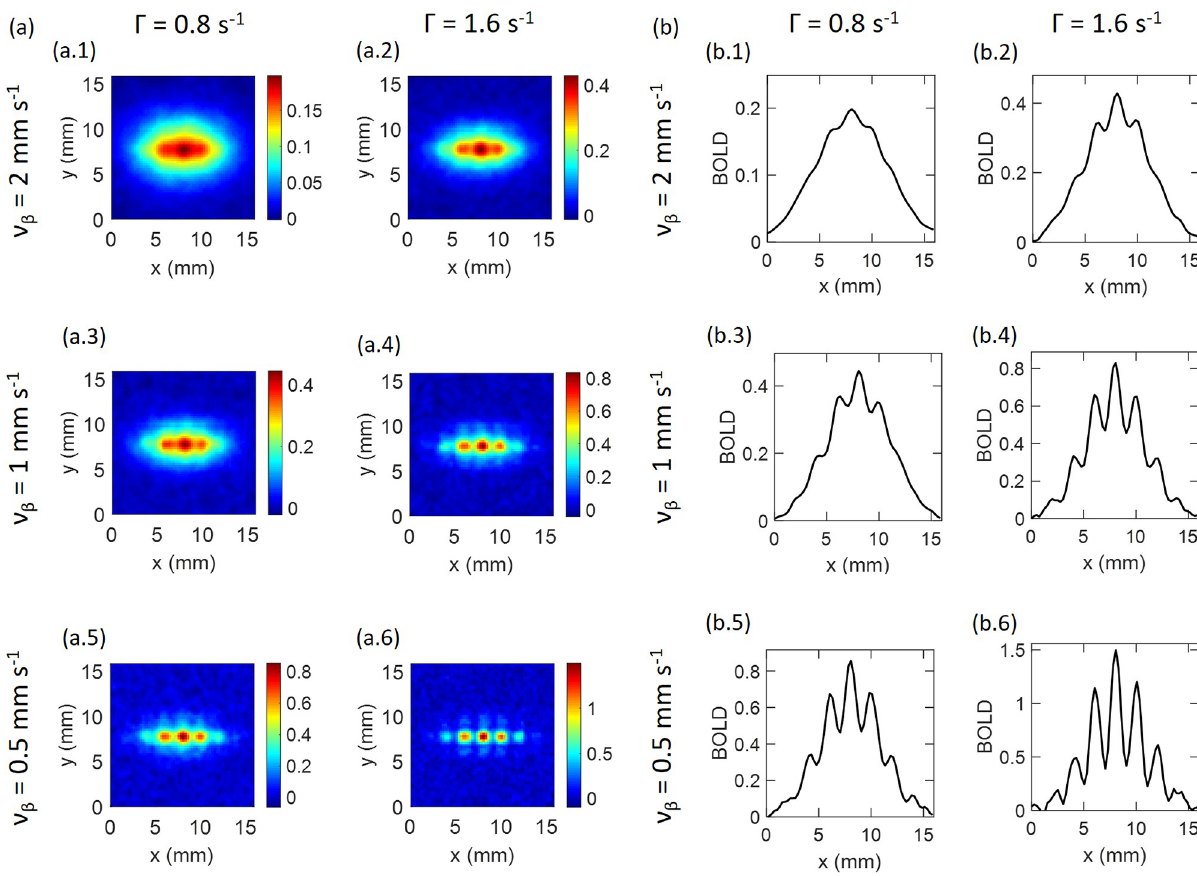
Fig 8. Sensitivity analysis of BOLD response—Noisy BOLD-Wiener. (a) BOLD images for various Γ and v β , as labeled, with OP of 0˚ and resolution of 0.25 mm in all cases. (b) Profiles of the images in (a) in the x